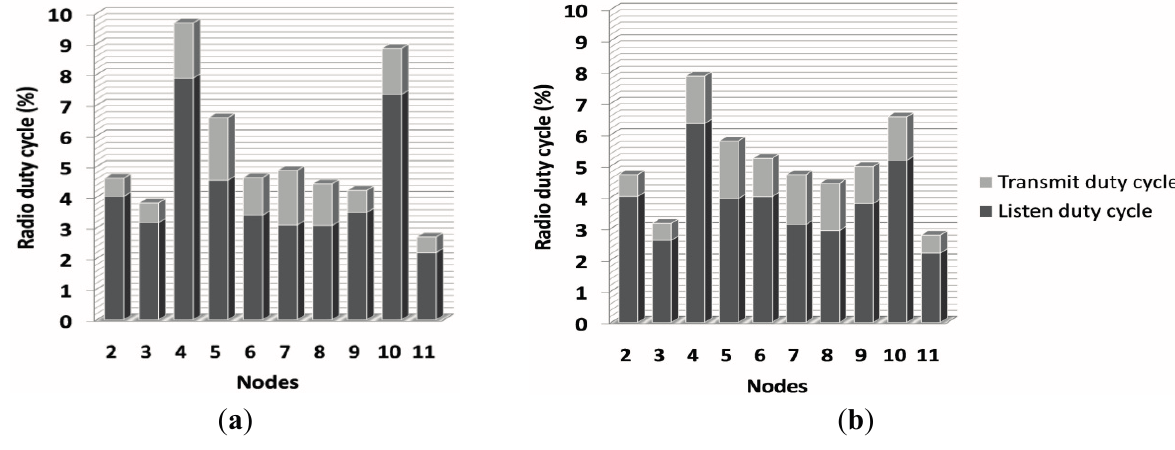
Figure 9. ( a ) RDC results of the testbeds using standard RPL model in the 1st test; ( b ) RDC results of the testbeds using RPAL model in the 2nd